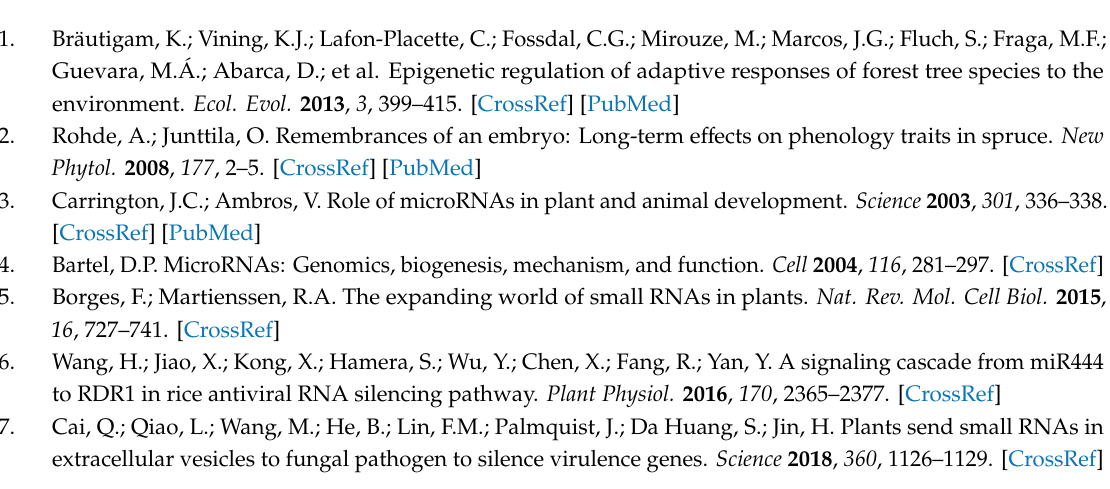
miRA tool. Supplementary File 5: Figure S1: Conserved miRNA target sequences distribution in category of biological process, Figure S2: Conserved miRNA target sequences distribution in category of molecular function, Figure S3: Novel miRNA target sequences distribution in category of biological process in SwissProt database, Figure S4: Novel miRNA target sequences distribution in category in response to stimulus in SwissProt database, Figure S5: Novel miRNA target sequences distribution in category of molecular function in SwissProt database, Figure S6: Novel miRNA target sequences distribution in category of biological process in non-redundant protein database, Figure S7: Novel miRNA target sequences distribution in category of biological process in non-redundant protein